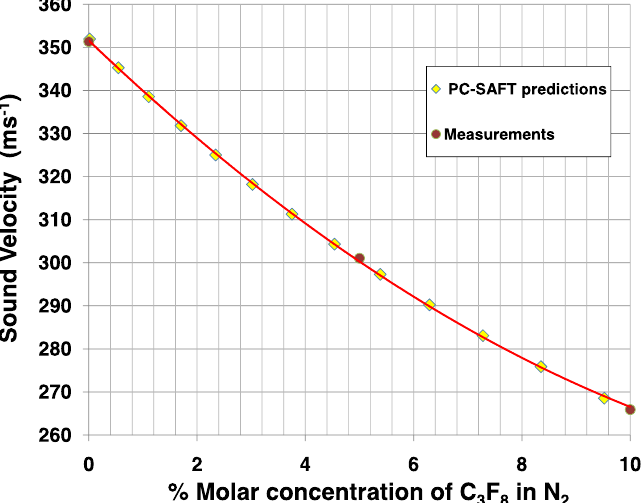
Figure 7. Comparison of sound velocity measurements and PC-SAFT predictions in C mixtures at 1bar abs and 25 °C up to 10% molar